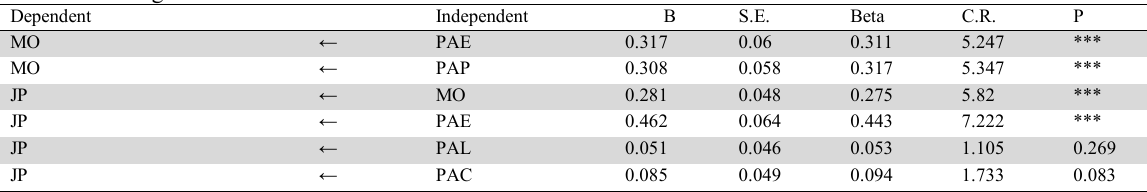
The results of regression model for research